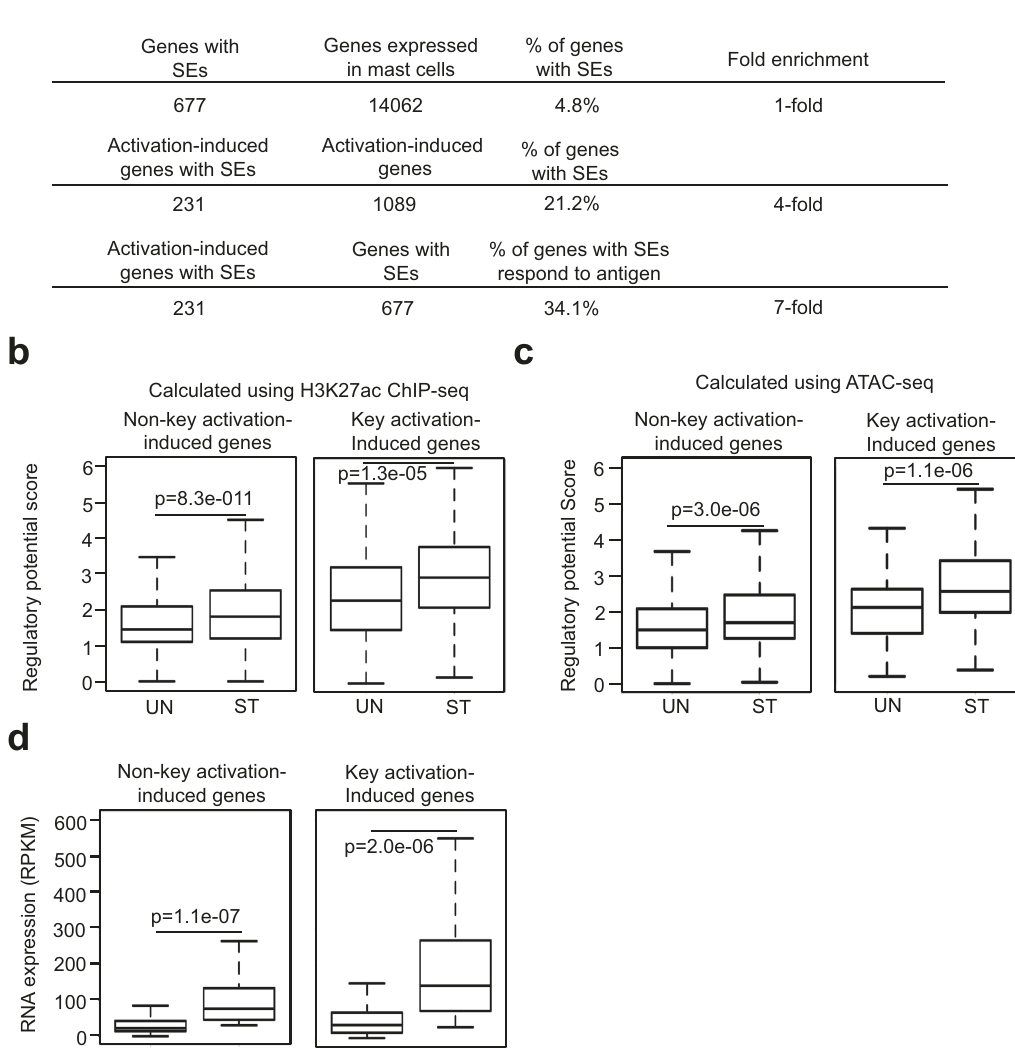
(Fig. 5a, Supplementary Data 10). The activation-induced genes associated with super-enhancers represent a striking 34% of all MC genes associated with super-enhancers. We refer to the activation-induced genes with super-enhancers as the key activation-induced genes and the activation-induced genes with typical enhancers as the non-key activation-induced genes. The key activation-induced genes had 1.7-fold higher regulatory potential scores (calculated either using H3K27ac peaks or Omni- ATAC-seq peaks) than the non-key activation-induced genes in resting MCs (Fig. 5b, c). These genes showed a 1.2-fold increase in the regulatory scores when MCs were activated (Fig. 5b, c). The key activation-induced genes with higher regulatory scores were expressed 2-fold higher than the non-key activation-induced